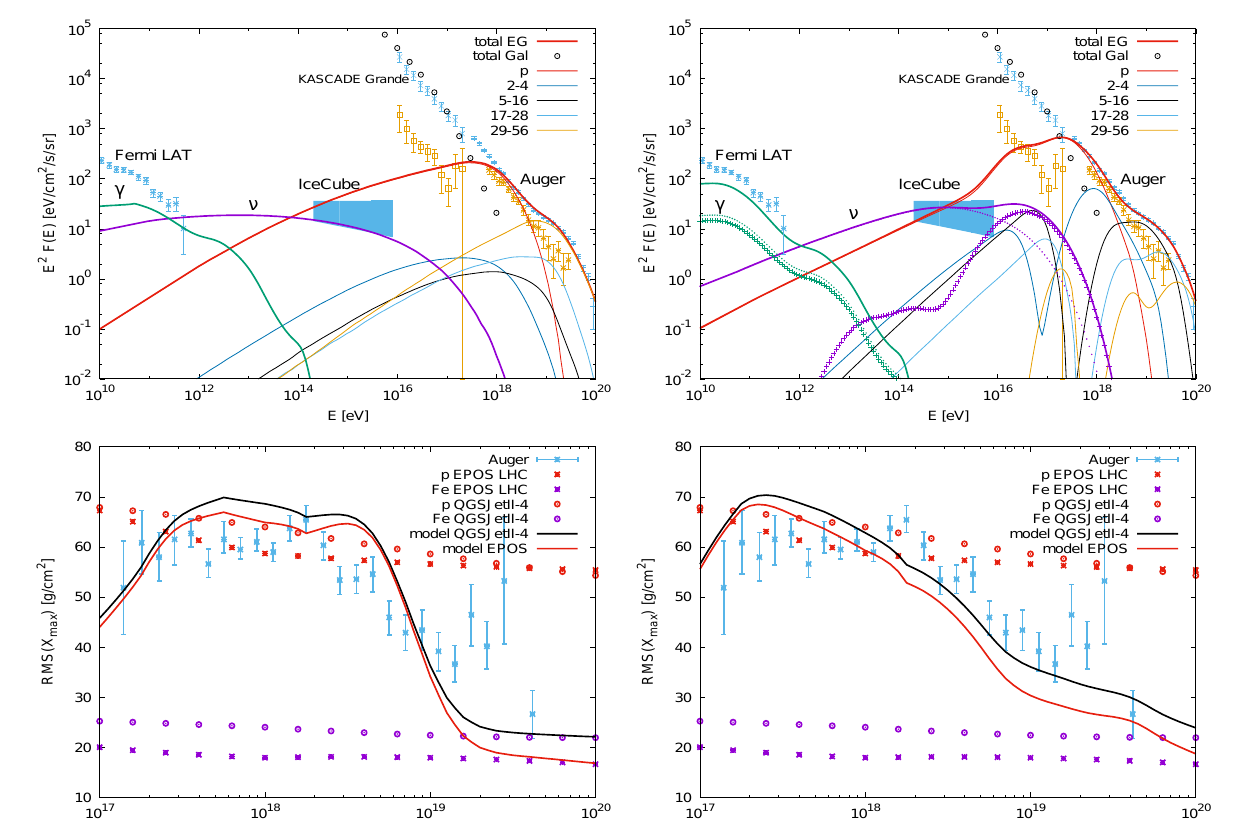
Figure 4. Di ff use flux (top) of five elemental groups and the resulting RMS( X max ) (bottom) values; left for only hadronic, right with additional A (cid:13) interactions